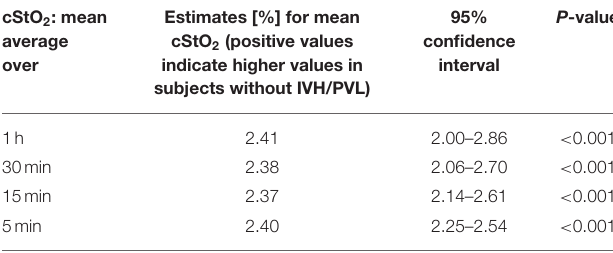
TABLE 2 | ANOVA with a mixed linear model. cStO 2 : mean average